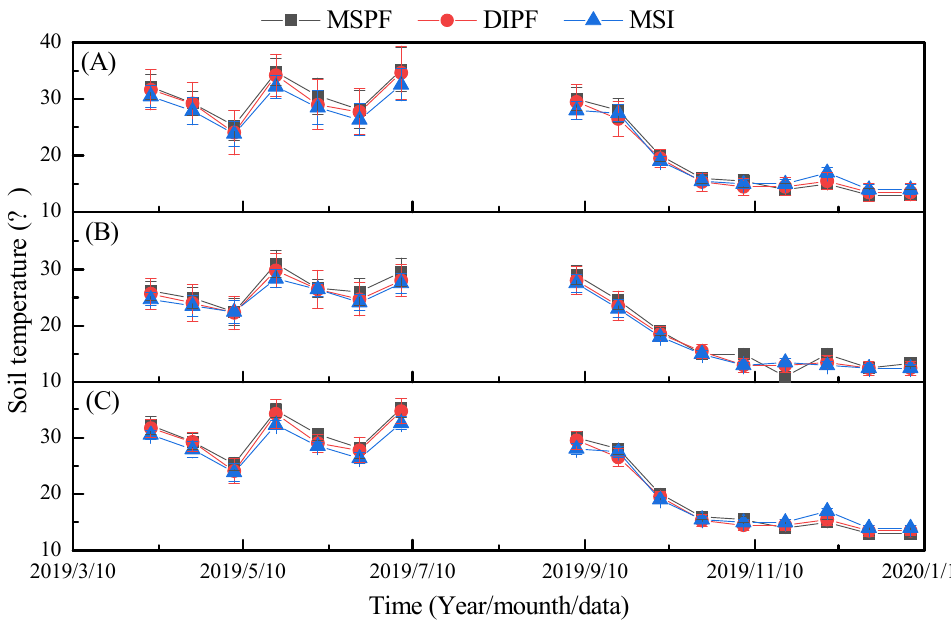
Figure 3. Soil temperature at 5 cm ( A ), 15 cm ( B ) and 25 cm ( C ) depths under different irrigation strategies.